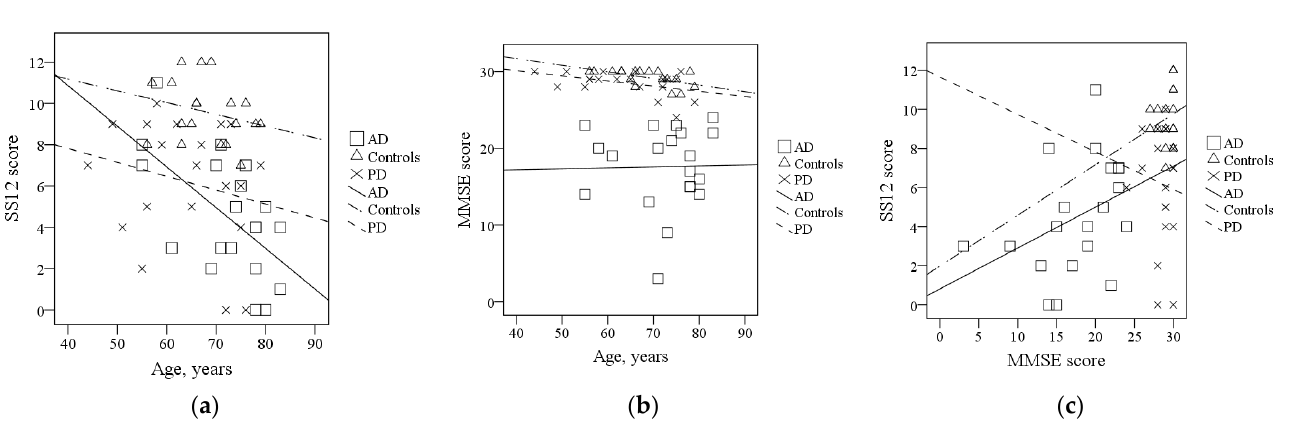
Table 1. Clinical and demographic characteristics.